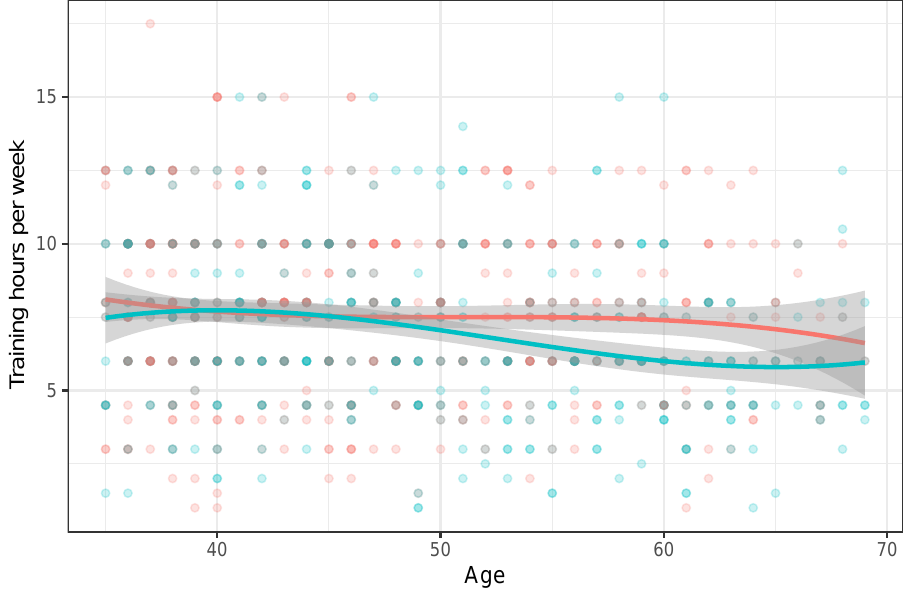
Figure 2. Training hours per week by age and sex (females—red, males—green). The smoothed lines show the trend across age with grey-shaded confidence intervals. Circles represent training hours of individuals (green for males and red for